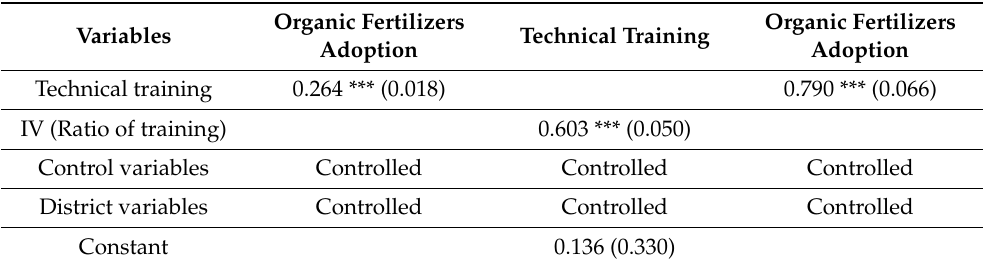
Table 5. Estimates of the IV-Probit model.